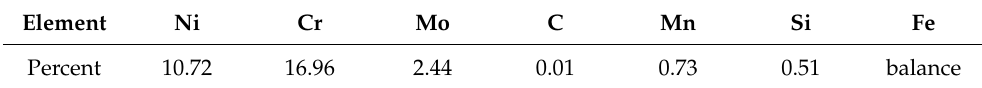
Table 1. Chemical composition of the 316L stainless steel powder.